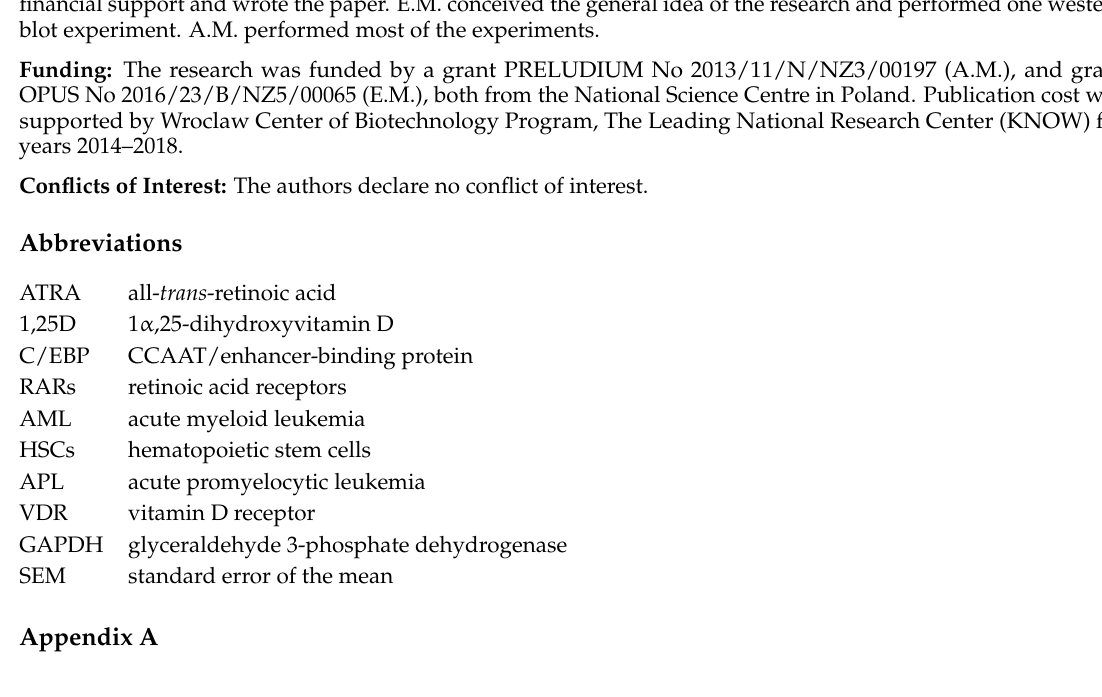
Table A1. Comparative quantification of CEBP genes related to a reference GAPDH gene in HL60 cells.